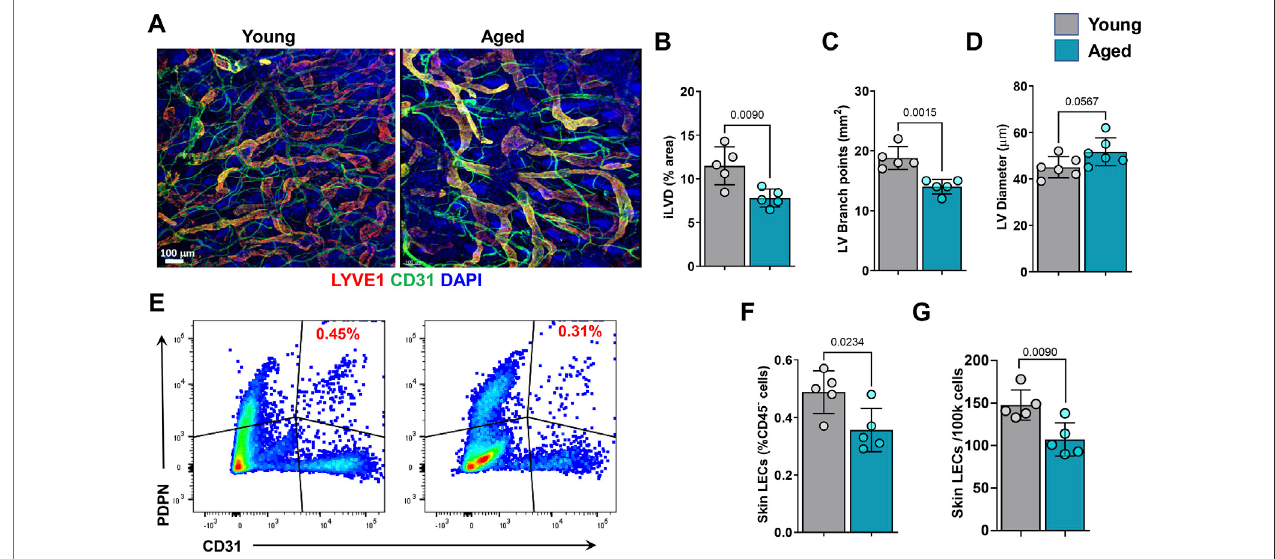
FIGURE 1| Aging causes decreases in initial lymphatic vessel density and lymphatic endothelial cell (LEC) numbers. (A) Representative confocal images ofmouse skin showing initial lymphatic vessels (LYVE-1) and blood vessels (CD31) density. Quanti fi cation of initial lymphatic vessel (B) density, (C) branch points, and (D) vessel diameter. (E) Representative fl ow cytometry dot plots showing frequencies of CD45-/podoplanin (PDPN)+/CD31+ lymphatic endothelial cells. (F) Quanti fi cation of skin LECsasapercentageofCD45 − cells. (G) Quanti fi cationoftheabsolutenumberofskinLECsamong100,000totalcells. n =5micepergroupforallexperiments.All quanti fi cations are mean ± SD, unpaired Student ’ s t test.